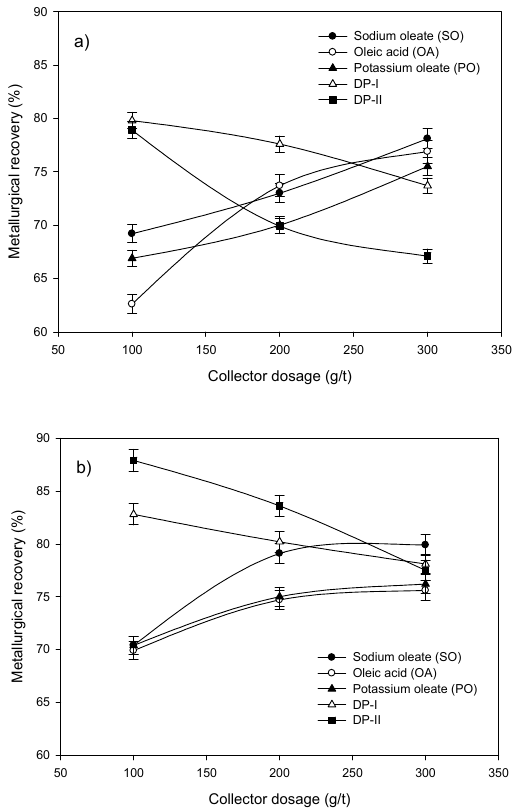
Figure 4. Effect of collector dosage on fluorite metallurgical recovery in the mechanical cell ( a ) and pneumatic cell ( b ) froth flotation. and pneumatic cell ( b ) froth flotation.